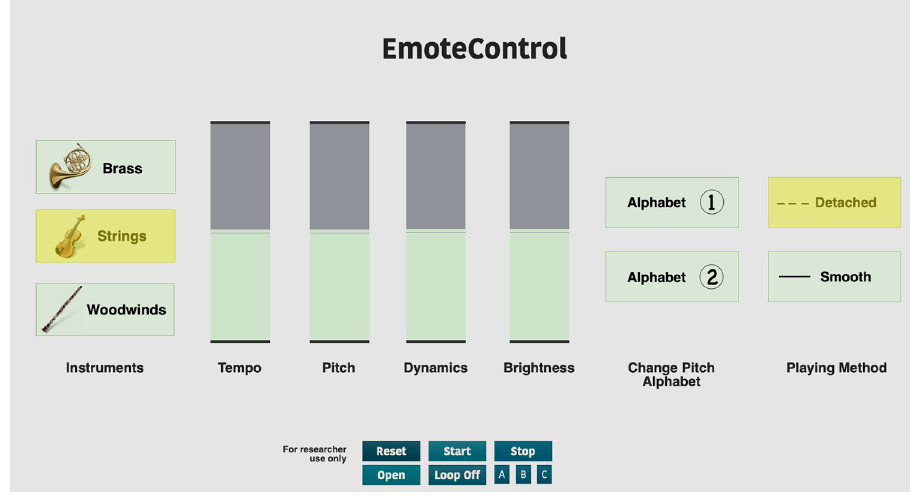
Fig 1. The EmoteControl V2.0 user